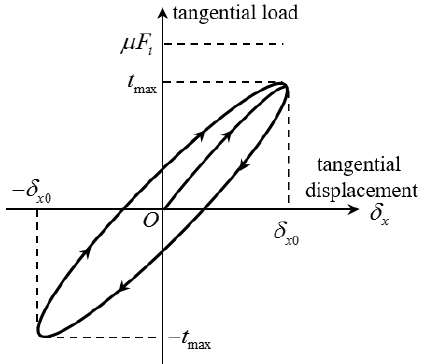
Figure 4. Relationship between tangential displacement and tangential load.